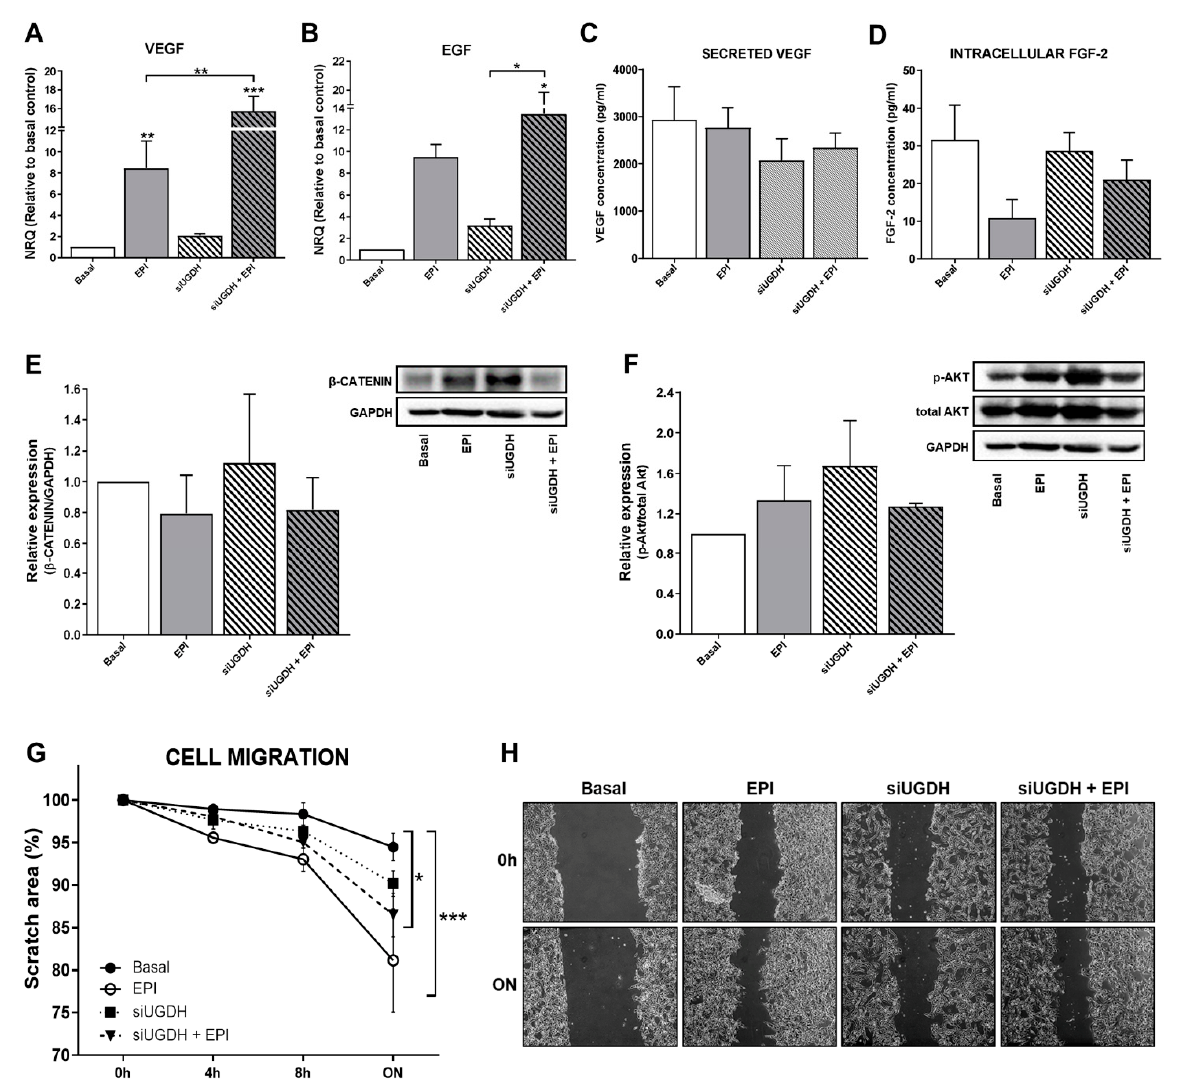
Figure 5. Evaluation of angiogenic response, cell proliferation and migration after silencing UGDH and EPI treatment. MDA-MB-231 cells were transfected with a specific siRNA against UGDH gene (siUGDH) using a random sequence siRNA as the negative control (siSCR). After 24h, 1 µ M EPI (1 EPI) was added to complete 48 h of incubation. VEGF ( A ) and EGF ( B ) expressions were obtained by real-time quantitative PCR using SYBR Green. Results were normalized using β -actin as the reference gene and all determinations were performed as duplicates. Levels of secreted VEGF in cell supernatants ( C ) and intracellular levels of FGF-2 in cell lysates ( D ) were measured by ELISA. Total protein was extracted and the expression of β -catenin ( E ) and p-AKT ( F ) were detected by Western blot. The images show the most representative of the three independent experiments. To describe cell migration ability, consistently shaped wounds were made during transfection and EPI treatment. The experiment evaluated the same coordinates of each photo at different time points in order to evaluate migration ability. Three images were captured at 0 h, 4, 8 and 22 h at the same coordinates. The gap sizes of the wounds were measured and analyzed using ImageJ software. The results were shown as free area of the wound, which is inversely proportional to the migration ability of the cells. The results were expressed as the decrease in the initial area of the wound, considering as 100% the area at time 0 ( G ). Micrographs show the most representative of three independent experiments ( H ). n = 3, as mean ± SEM. * p < 0.05 ** p < 0.01 *** p < 0.001 .